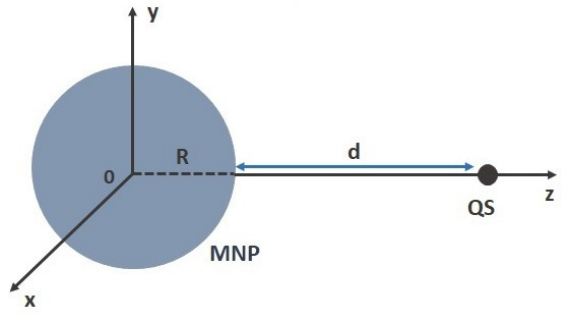
Figure 1. The quantum system (QS) at distance d from the surface of the metallic nanoparticle (MNP) with radius R .